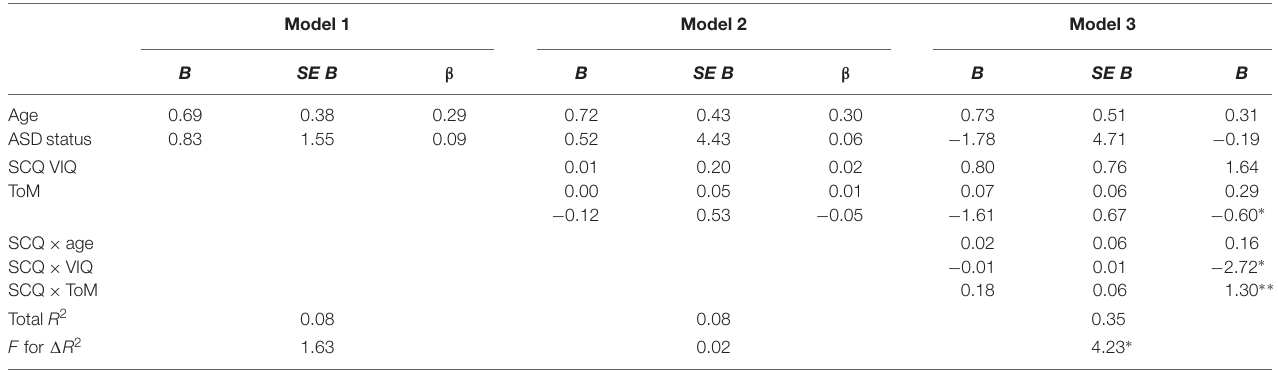
TABLE 3 | Hierarchical multiple regression predicting amount of observed spontaneous pretend play.